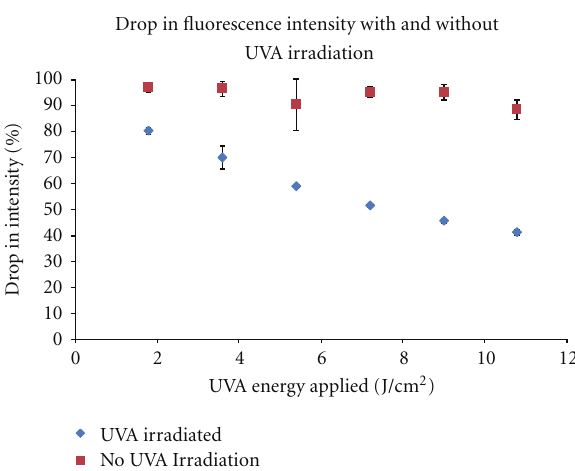
Figure 6: Comparison between di ff usion coe ffi cients obtained with fluorescence imaging versus a Franz cell for a 0.1% riboflavin in 0.44% saline, 0.02% BAK formulation with and without epithelium.